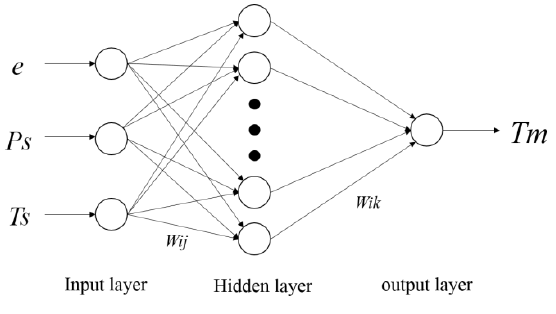
Figure 1. BP neural network topology